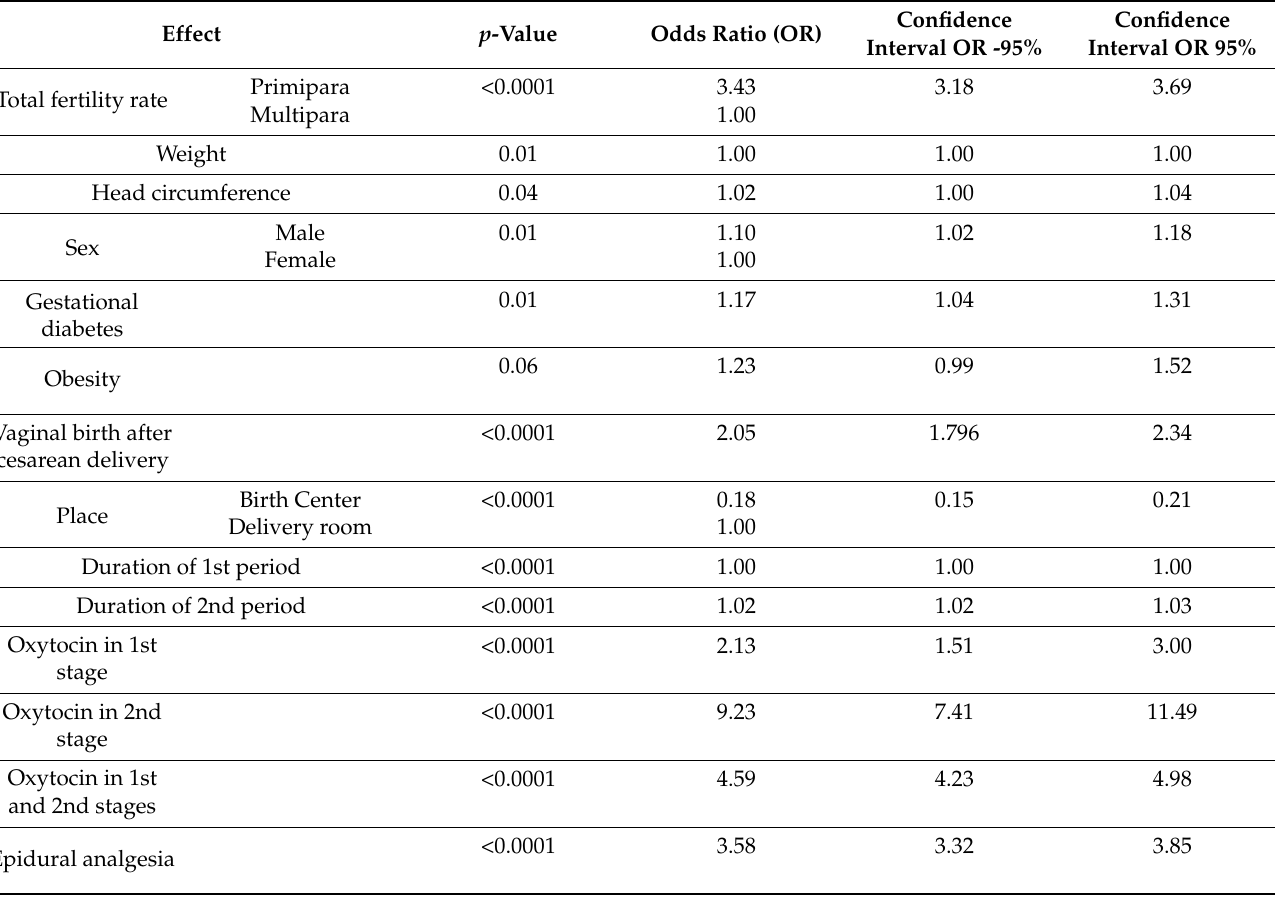
Table 4. Logistic regression for performing the episiotomy.